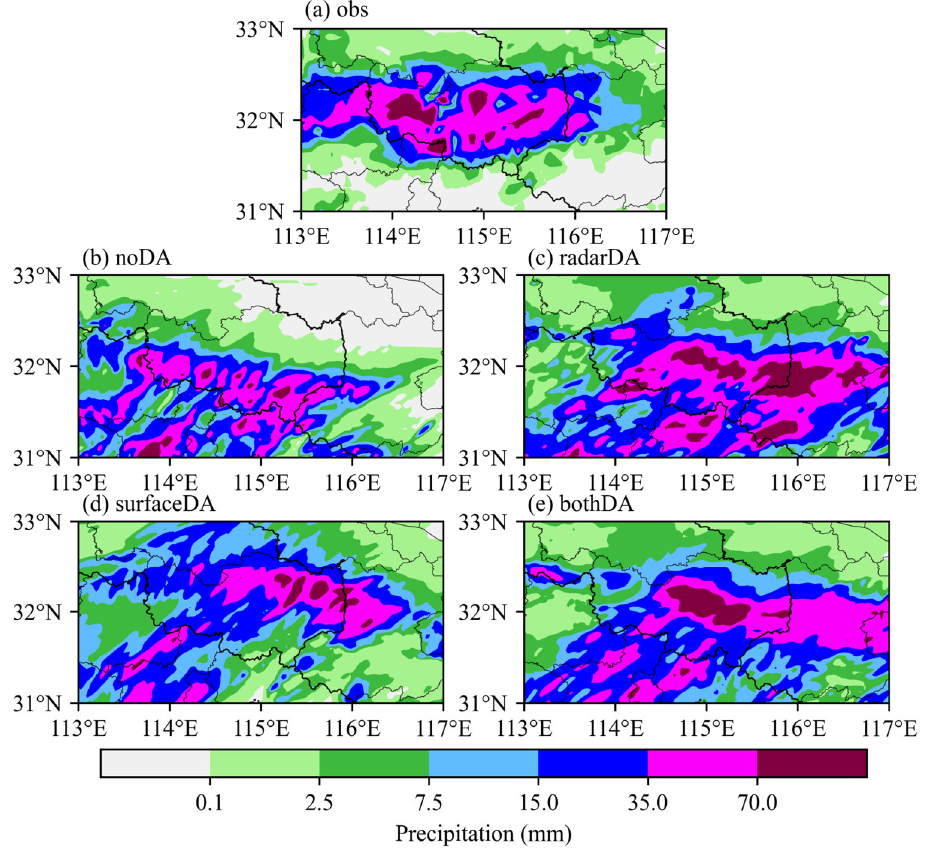
Figure 7. Distribution of 6h (1500 UTC to 2100 UTC 11 July 2014) accumulated precipitation (shaded, units: mm) from the ( a ) observation, ( b ) noDA, ( c ) radarDA, ( d ) surfaceDA and ( e ) bothDA experiments.